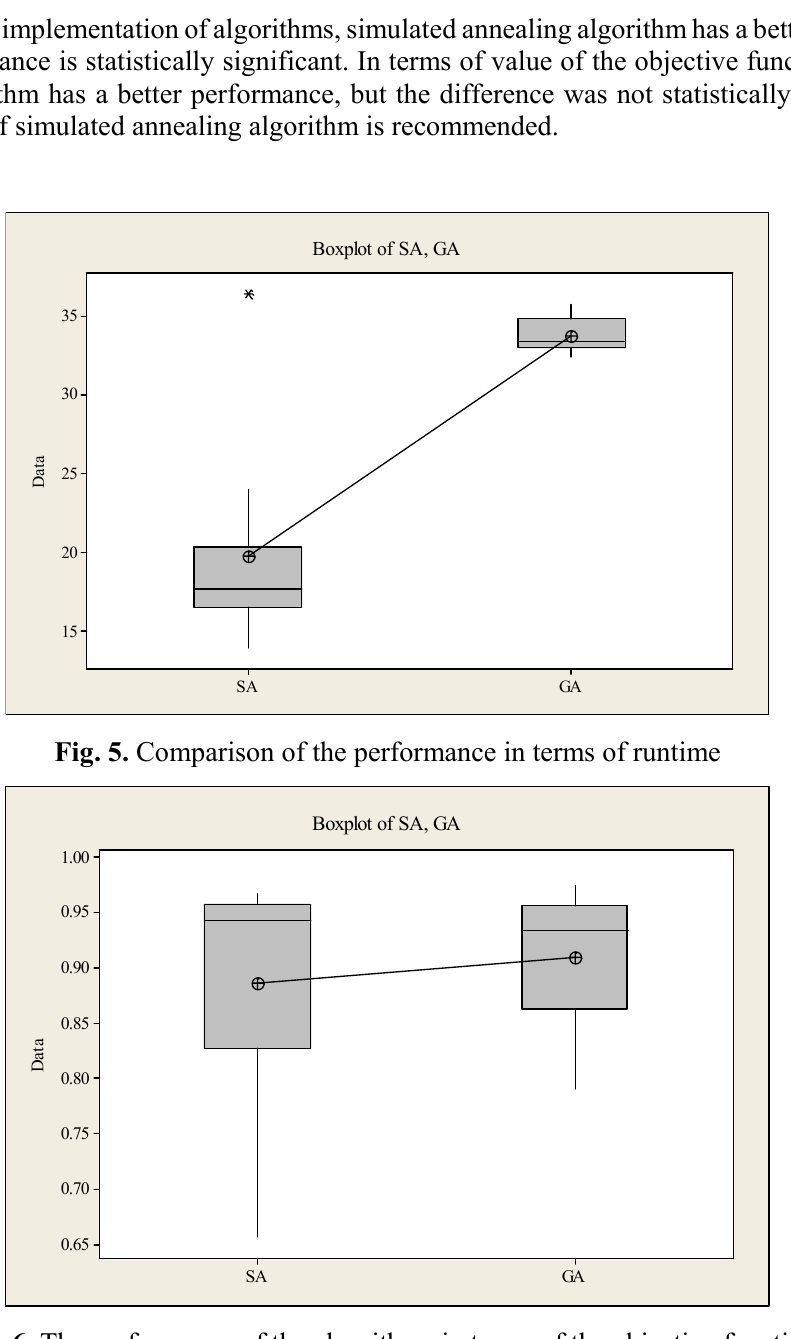
Fig. 6. The performance of the algorithms in terms of the objective